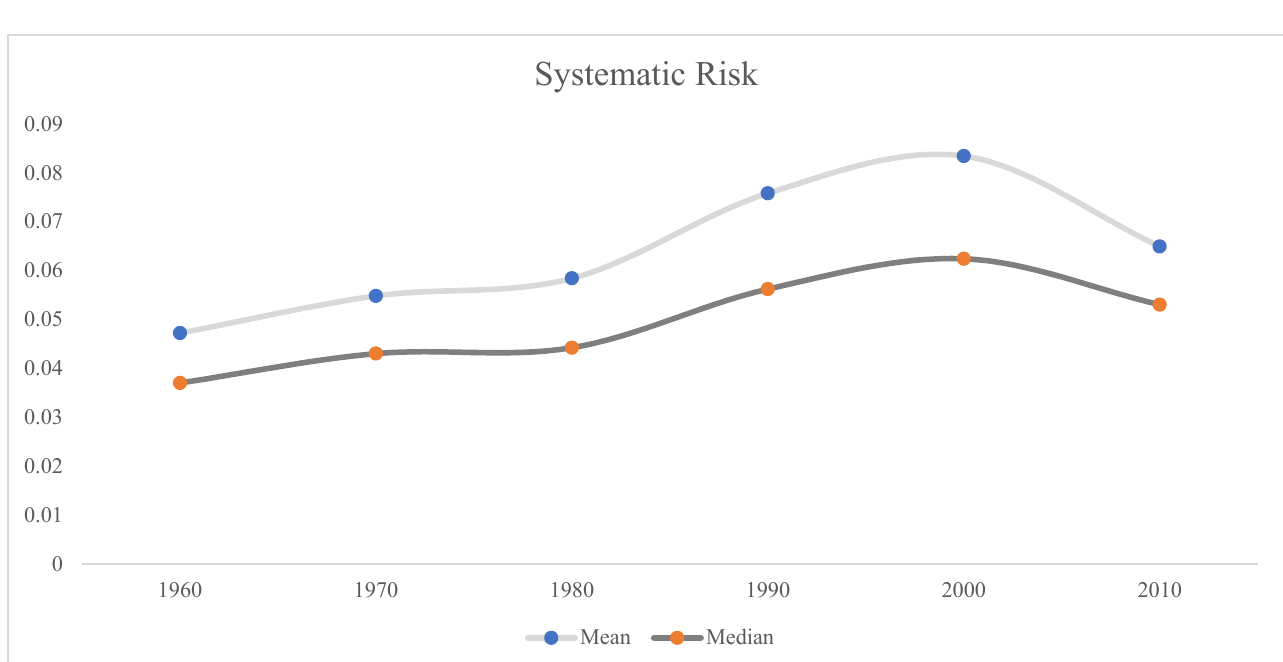
Figure 1. Historical trend in systematic risk. This figure shows the historical patten of systematic risk. Every decade from 1963 to 2019, the mean and median of systematic risk of individual stocks are plotted. The calculation of systematic risk is discussed in Equations (2) and (3). Table 2. Descriptive statistics of idiosyncratic risk. This table presents the descriptive statistics of idiosyncratic risk for individual stocks for the period of July 1963 to December 2019. Within each month, daily stock returns are regressed on the Fama–French three factors. The monthly idiosyncratic risk is the standard deviation of the residual term multiplied by the square root of number of trading days in that month. For each month, a stock should have at least 15 days returns to be included in the